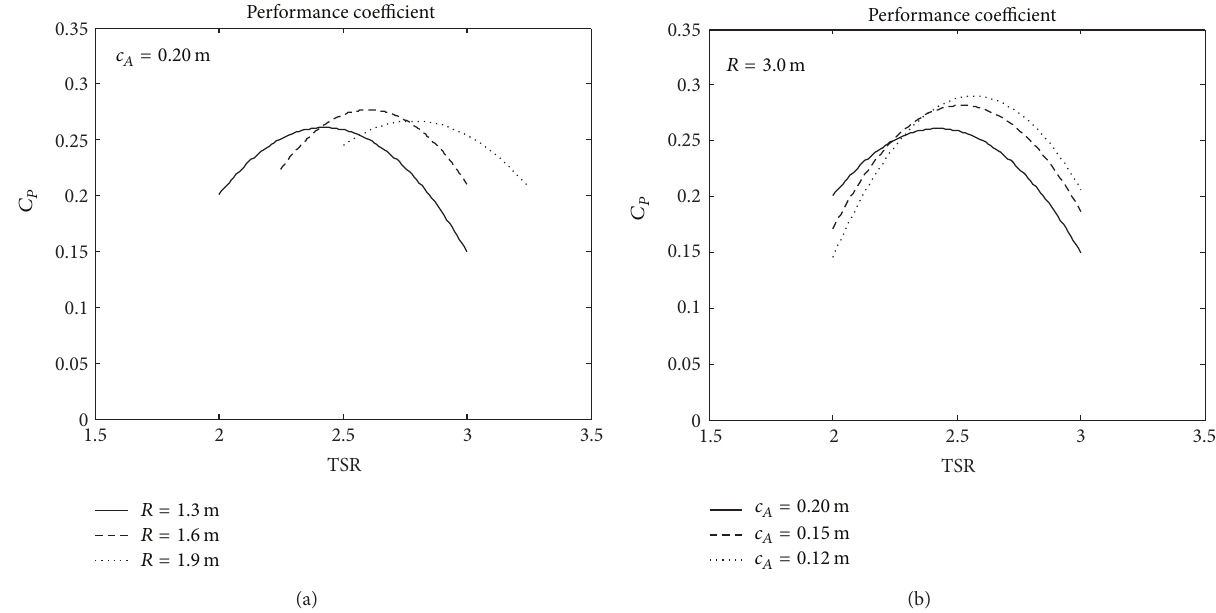
Figure 14: (a) Performance coefficient against tip speed ratio for different turbine radii (FE-3). (b) Performance coefficient against tip speed ratio for different arm chord lengths